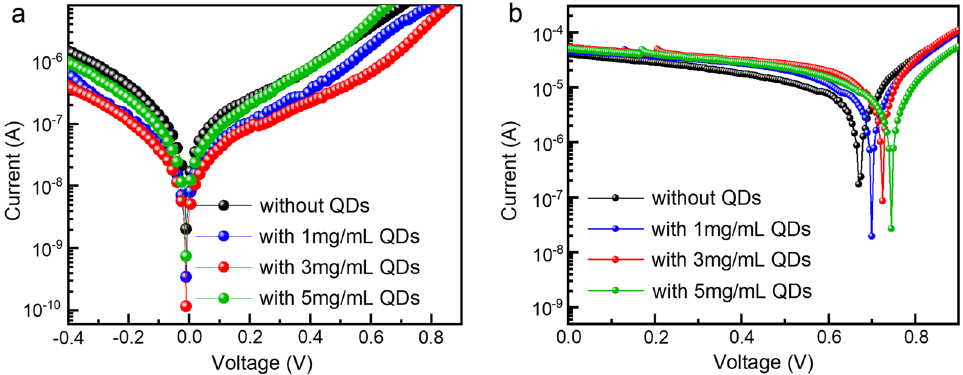
Fig. 6 a Dark I-V curves and b Light I-V curves of different